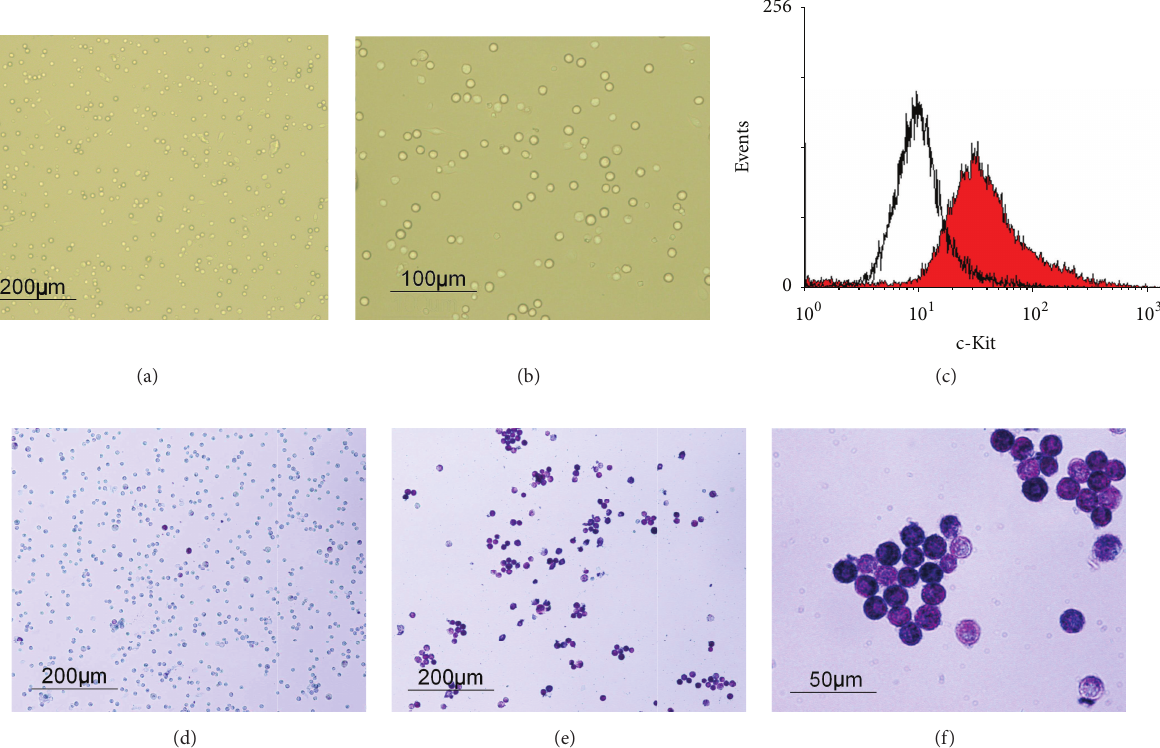
Figure 1: Purification of rat peritoneal mast cells. ((a) and (b)) Purified rat peritoneal mast cells were examined by phase-contrast microscopy at different magnification rates. (c) c-Kit expression by peritoneal cells before (line) and after (solid) purification was carried out by flow cytometric analysis. ((d)–(f)) Rat peritoneal cells either unpurified (d) or following purification ((e) and (f)) were stained with toluidine blue and examined by